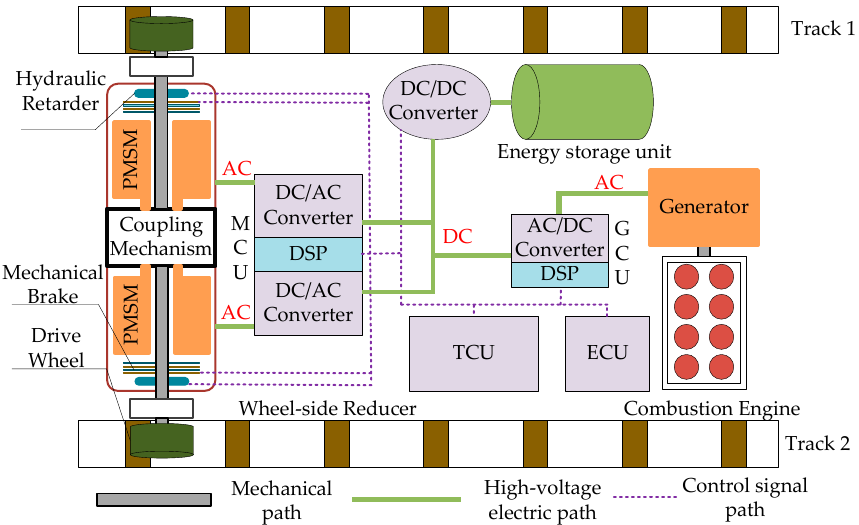
Figure 1. Schematic diagram of a dual-motor electric drive tracked vehicle (DDTV) structure. MCU, motor control unit; TCU, transmission control unit; ECU, engine control unit.